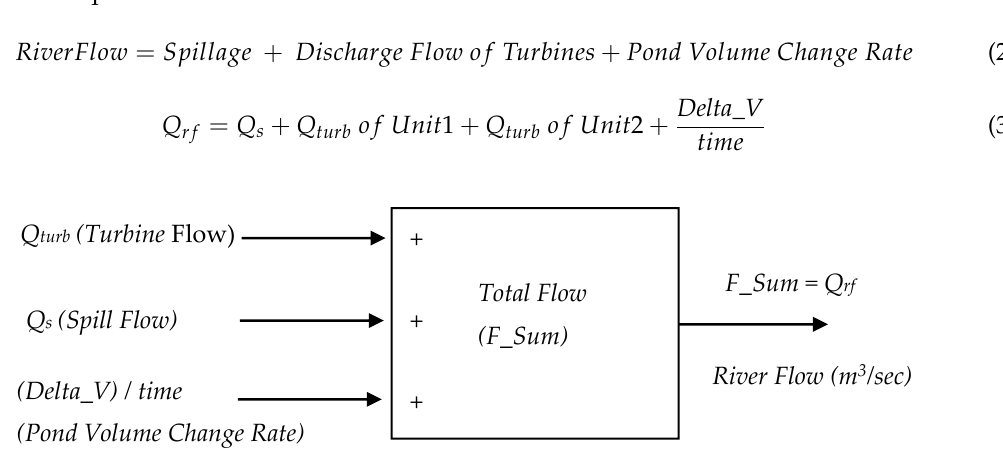
Figure 3. River flow as summation of flows and pond volume rate.